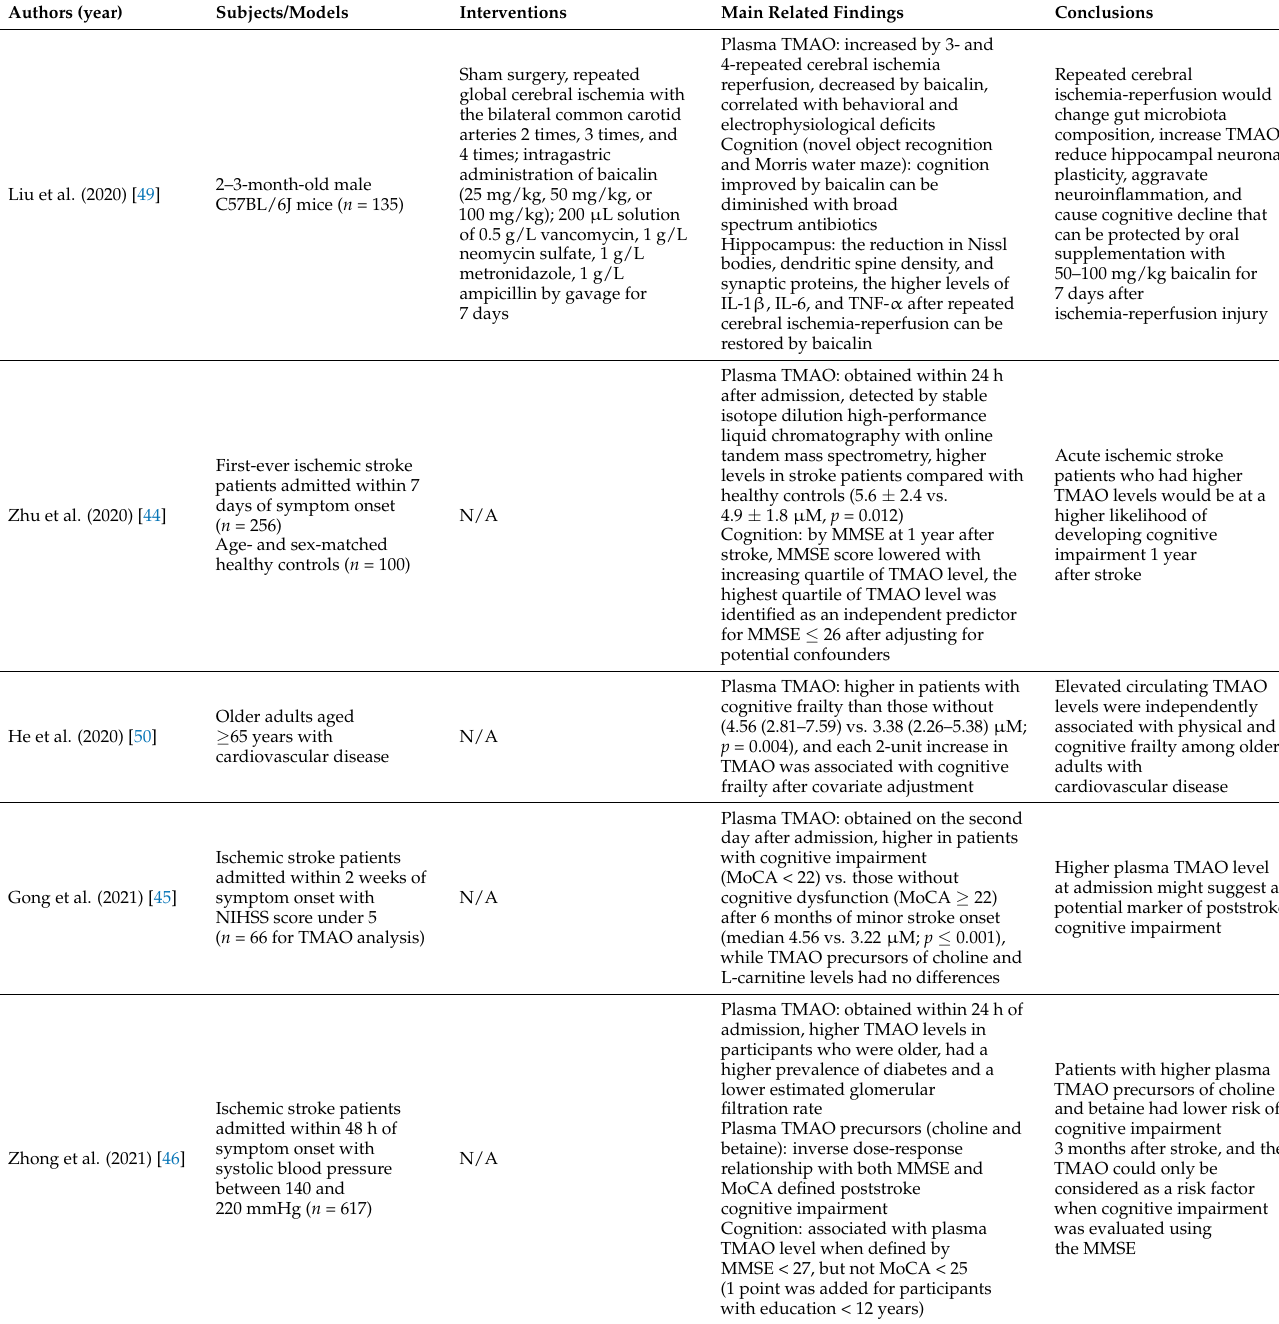
Table 3. Main findings of TMAO in cerebral and cardiovascular